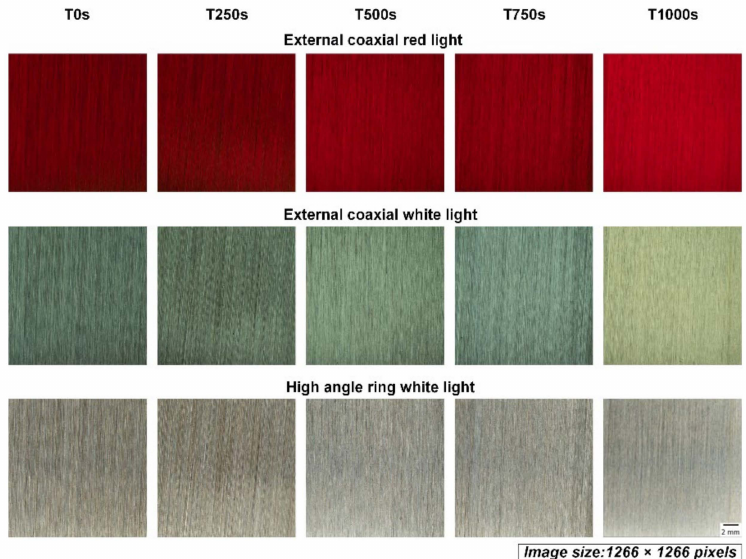
Figure 8. The notations and definitions of the workpiece utilized for measuring and computing the surface roughness of the workpiece.